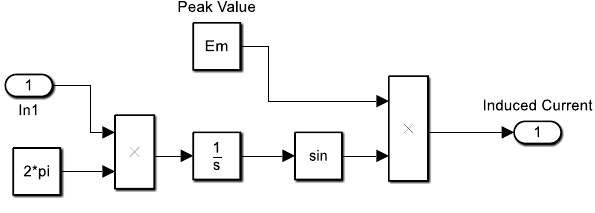
Figure 5. Rotor speed sensor model in Simulink.